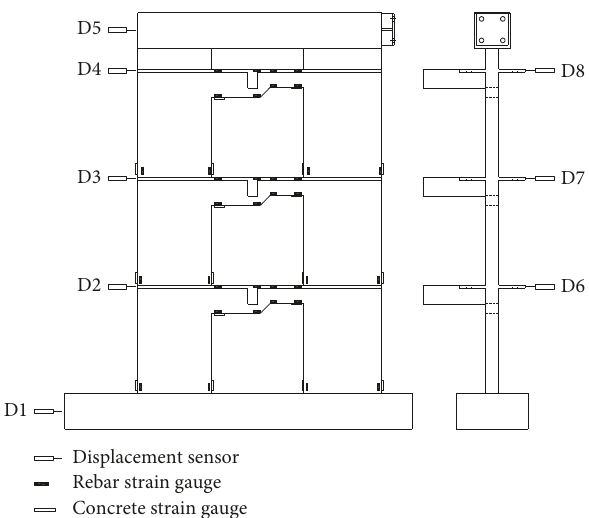
Figure 7: Overall measurements of each